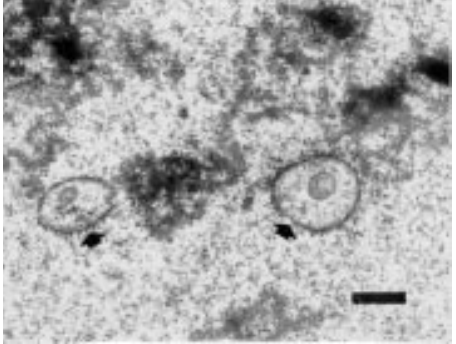
Fig. 7. Nuclear bodies (arrows) in the nucleolar region of a macronu- cleus. Bar 0.5 (cid:22) m.